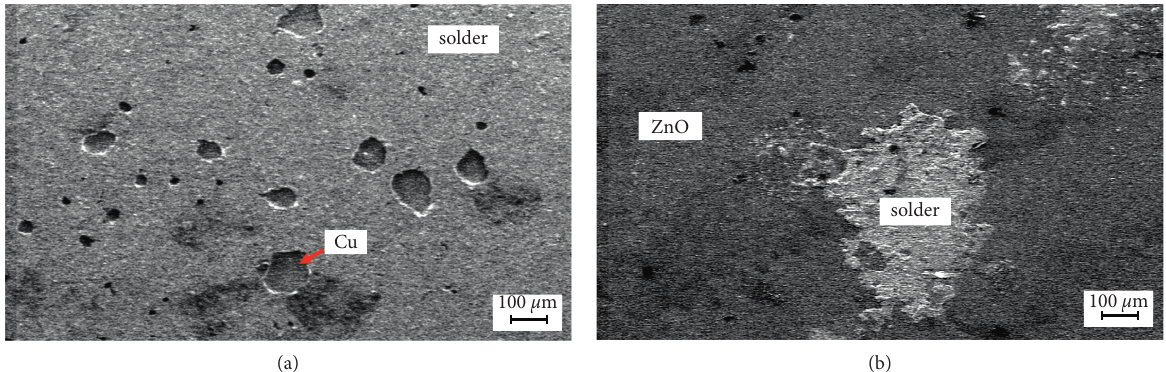
Figure 9: Fractography of a ZnO/Cu joint with Sn